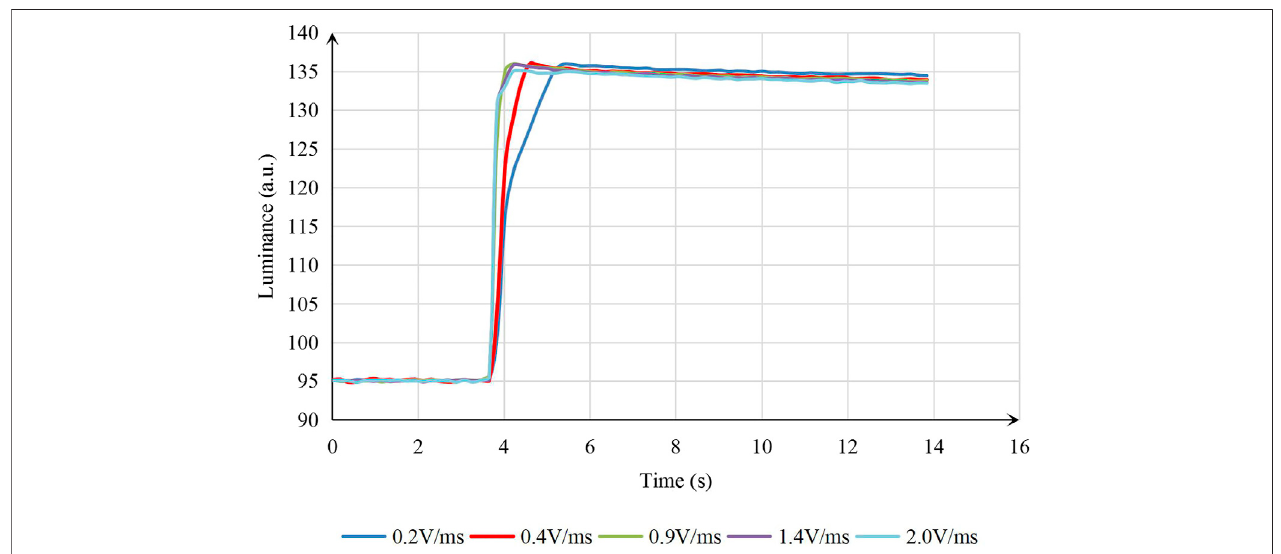
FIGURE 9 | Brightness – duration curve of an EWD when it was driven by different rising gradient driving waveforms. The 0.4 V/ ms slope driving waveform had the most stable aperture ratio.